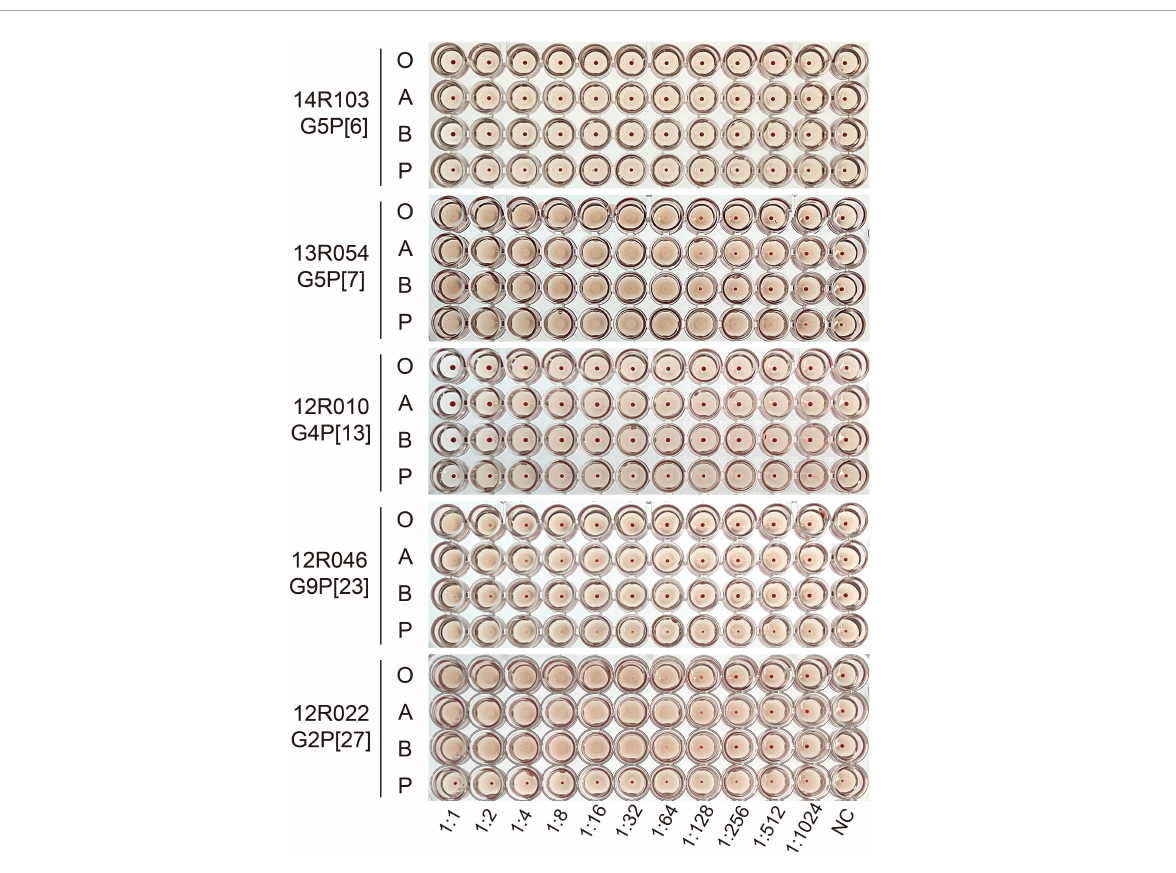
FIGURE3 Hemagglutination assays (HA) with the different recombinant VP8 ∗ proteins. Human red blood cells of type O, A, and B (marked as O, A, and B), and porcine red blood cells (marked as P) were used. GST-VP8 ∗ proteins were serially diluted with PBS and mixed with 0.5% of different types of red blood cells. The PBS buffer without protein was used as negative control